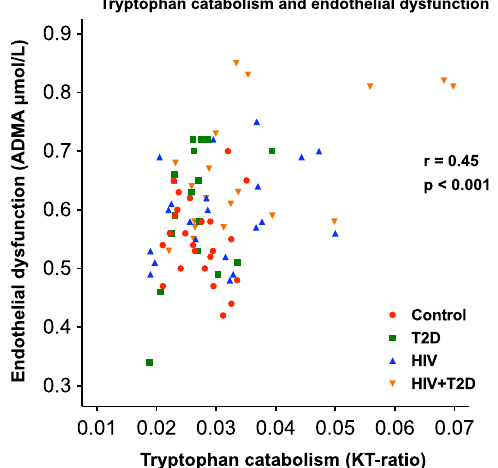
Figure 2. Association (Pearson correlation) between tryptophan catabolism (KT-ratio) and endothelial dysfunction assessed by ADMA in the total study population; controls (red), HIV only (blue), T2D only (green) and HIV-infected with T2D